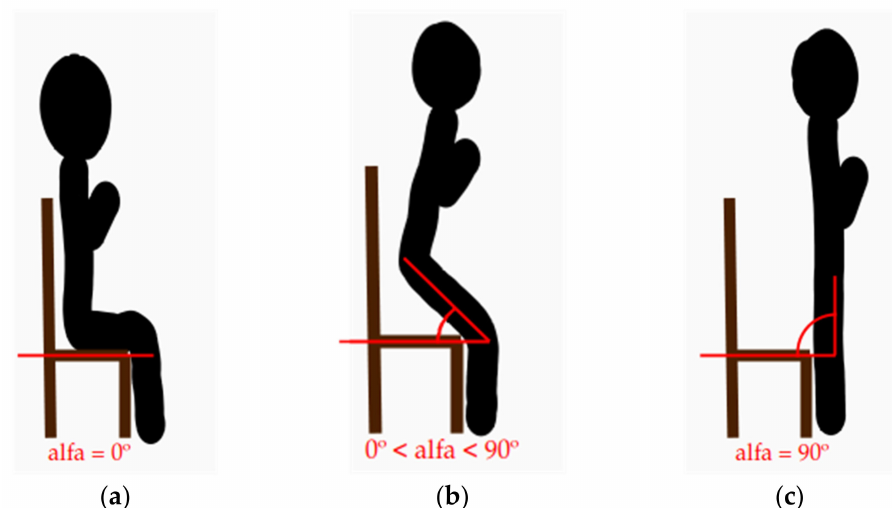
Figure 3. Definition of the thigh angle for the 30-s CST. It is defined as the angle between the subject’s thigh and a horizontal plane perpendicular to gravity (e.g., the seat of the chair). It is depicted as the angle (alfa) between the red line along the longitudinal direction of the subject’s thigh and the red line on the seat of the chair; therefore, ( a ) the expected value of the thigh angle in the sitting position is 0; ( b ) the value of the thigh angle at any time during SiSt and StSi transitions is bigger than 0 and lower than 90 ◦ ; and ( c ) the expected value of the thigh angle in the upright position is 90 ◦ .